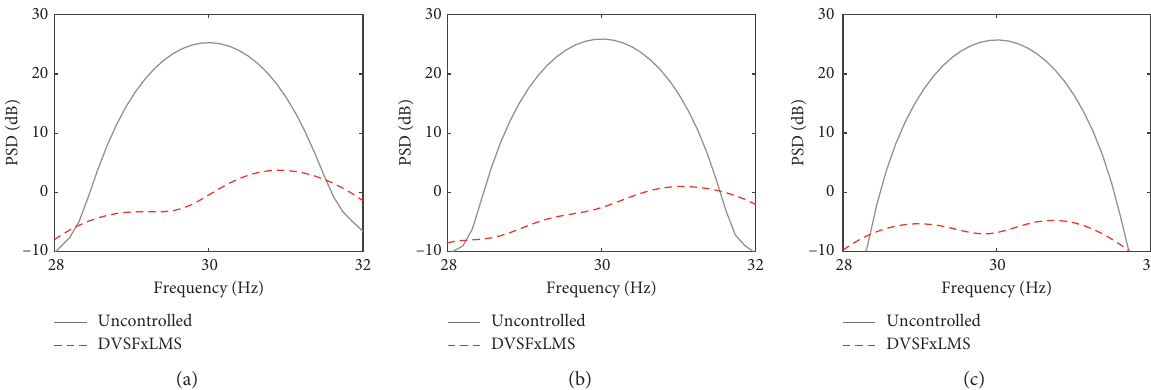
Figure 12: Acceleration response PSD contrast at point A (open/closed loop). (a) σ 2 � 1, (b) σ 2 � 0.25, and (c) σ 2 � 0.01.